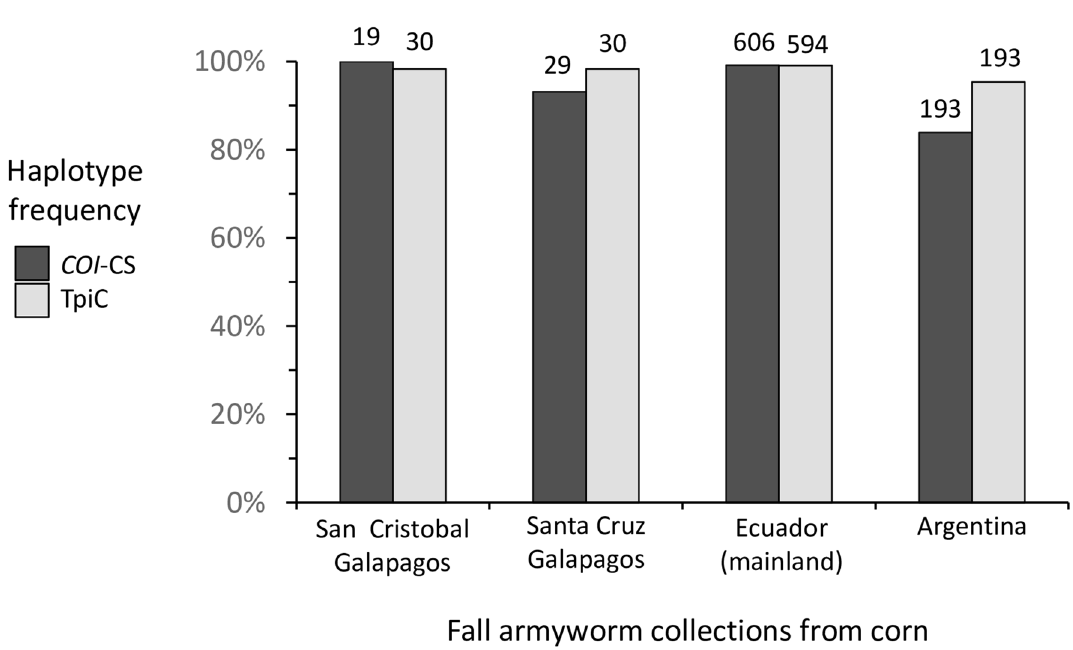
Figure 3. Frequency distributions of the C-strain COI -CS and TpiC haplotypes. Specimens are fall armyworm larvae collected from corn from two sites in the Galápagos. These were compared to specimens previously collected from Argentina corn 21 , and from corn and rice in mainland Ecuador 42 . Numbers above columns indicate number of specimens